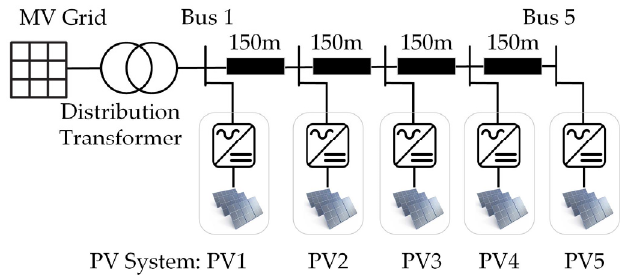
Figure 6. Simulated distribution system used in [16]. Table 1. Parameters of the low voltage lateral.